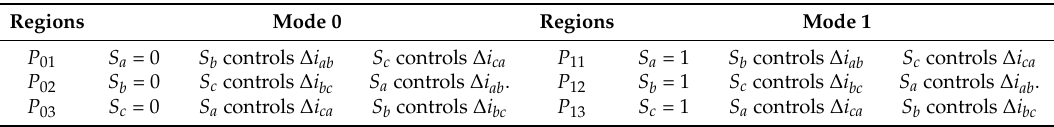
Table 1. Control strategies in different parallelogram regions under mode 0 and mode